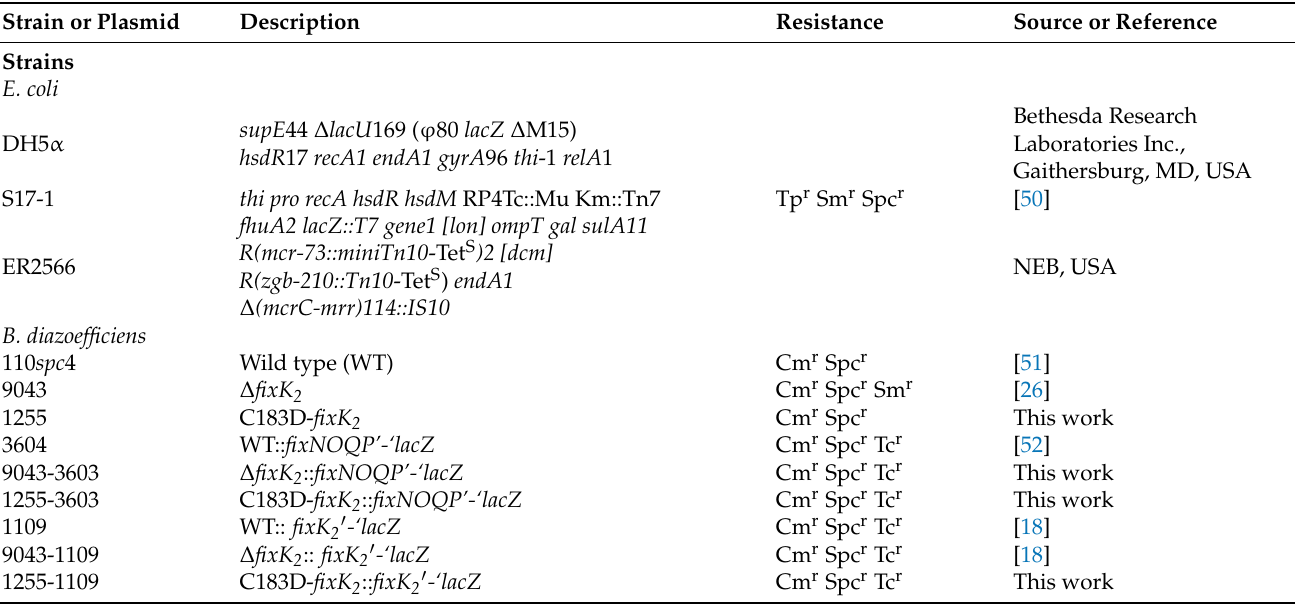
Table 3. Strains and plasmids employed in this